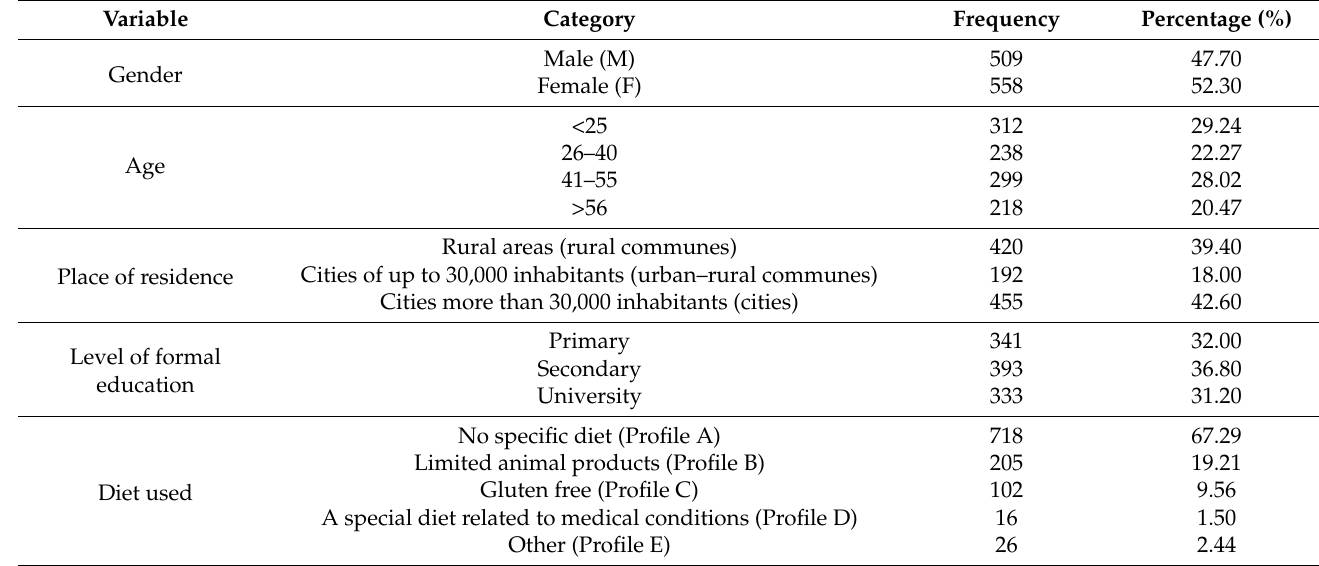
Table 1. Demographic description of the sample ( n =